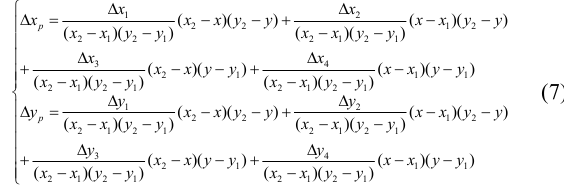
Figure 3. The block divisions and transformation parameters of source and target DEM. (a) Source DEM blocks; (b) Target DEM blocks; (3) Relative position. 2. Calculation of discretization range. Discretization range(X, Y) is the frame extended 10 regular grids. This method could simplify DEMs’ splicing and reduce the calculation, so efficiency of calculation is improved. The range calculations are as formulation (1-6). x i ' and y i ' in equations are block corner coordinates in target DEM coordinate system. ∆x i ' and ∆y i ' are transformation parameters corresponding to the target block corner points.